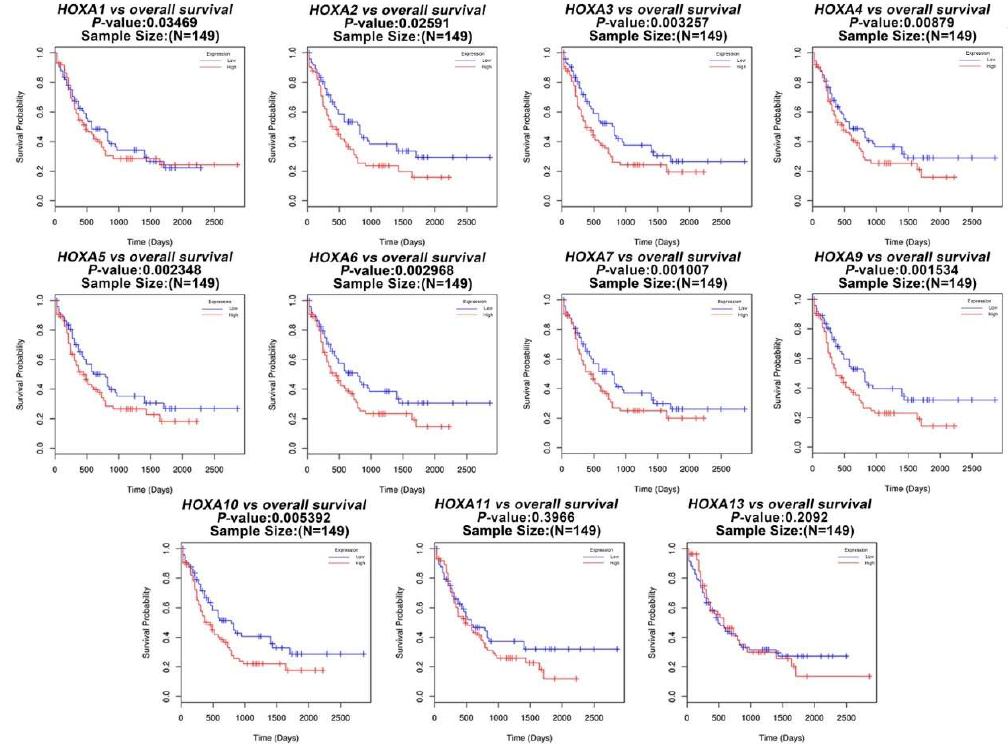
Figure 3. The prognostic value of the expression levels of HOXA genes in AML patients.